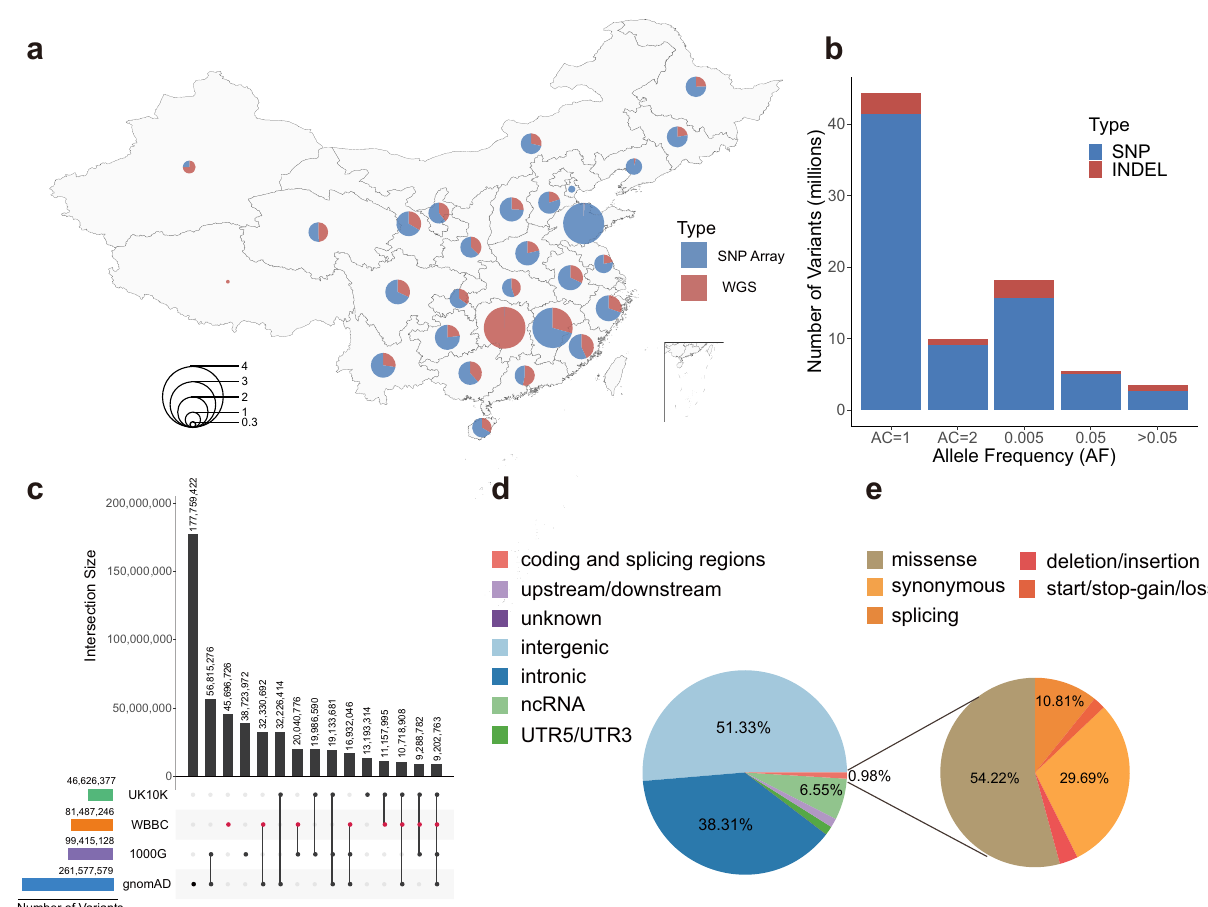
Fig. 1 The statistics of samples and variants in the WBBC. a Sample distribution and statistics by geography. The proportion of samples sequenced by whole-genome sequencing (WGS) and those genotyped by high-density In fi nium Asian Screening Array (ASA) were marked in red and blue, respectively. b The number of SNV and INDEL variants identi fi ed in the WBBC cohort in fi ve frequency bins: AC = 1, AC = 2, AC > 2 and AF < 0.005, 0.005 ≤ AF ≤ 0.05, and AF > 0.05. c The number of variants in 22 autosomes and X chromosome in the WBBC, 1000 Genome Project (1000G), gnomAD, and UK10K datasets. The horizontal bar plot shows the total number of variants in each of the four datasets. The individual dots and connected dots indicate each dataset and a combination of two or more datasets, respectively. Each vertical bar represents the number of variants in each dataset or overlapping variants in those datasets. d Functional annotations of all variants that were absent in dbSNP Build 151. The proportion of each category was fi lled with a different color. e The pie chart only displayed the variants in the coding and splicing regions (10 bp from exon-intron boundary). Source data are provided as a Source Data fi